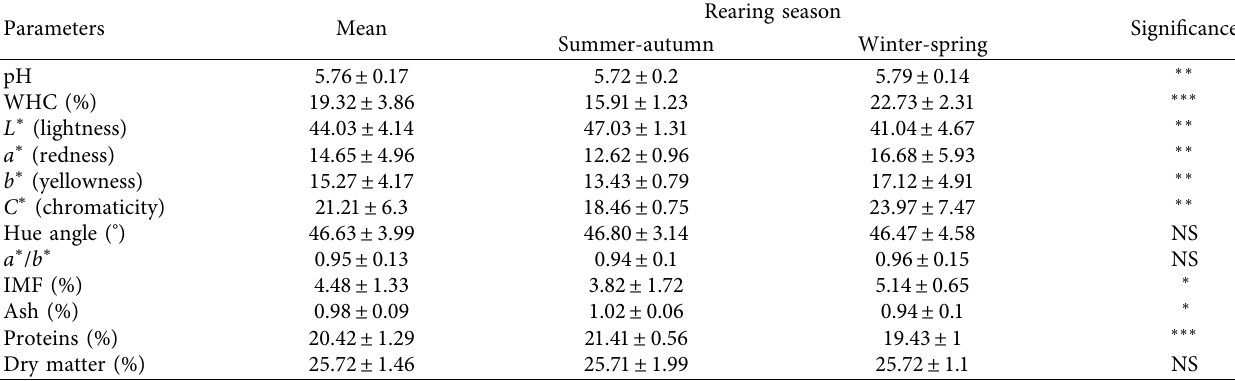
Table 1: Rearing season effect on the meat quality characteristics of Beni-Guil sheep breed. Parameters